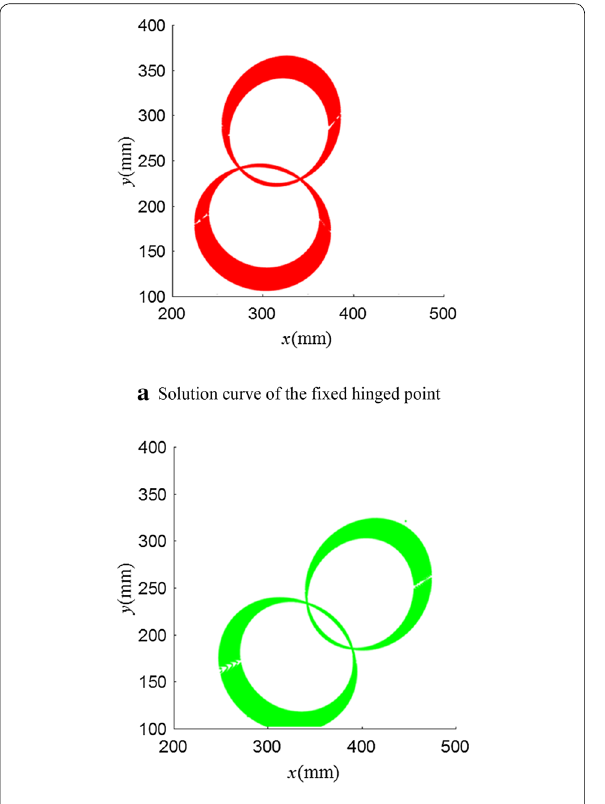
Figure 12 Solution curves of the two hinge points